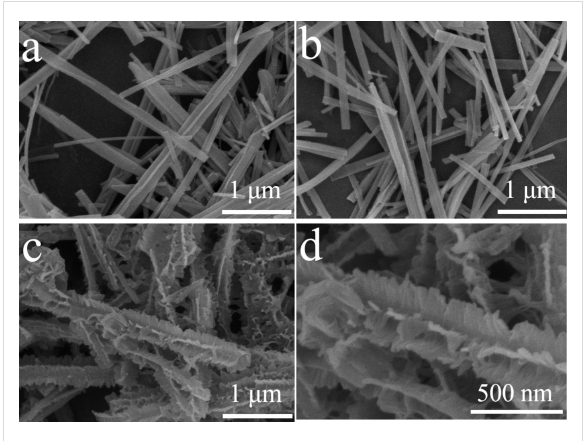
Figure 2: FESEM images of (a) pristine TiO 2 nanobelts, (b) sample TGN, and (c, d) sample TGN-branch 4